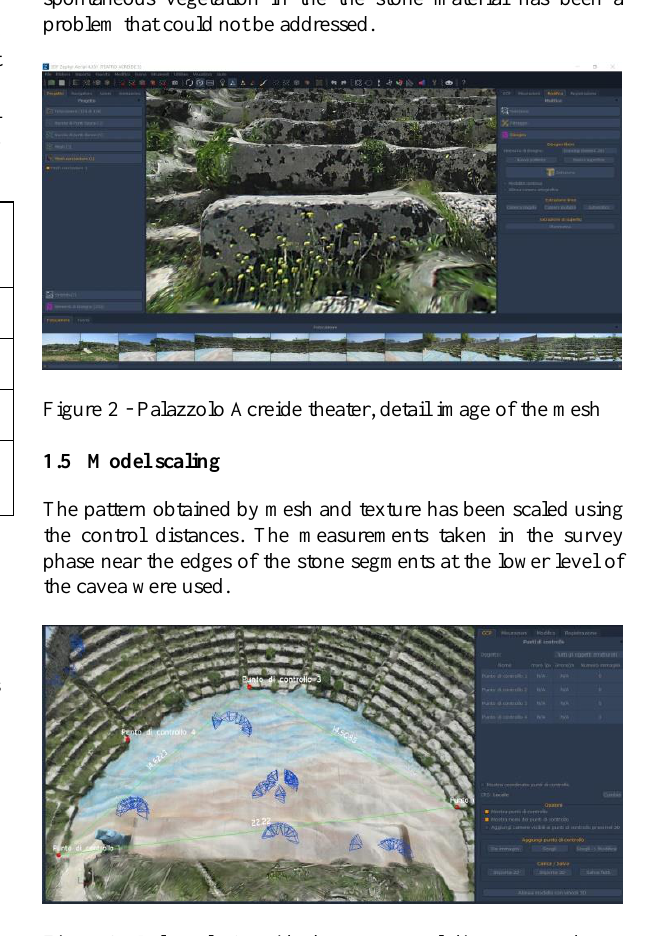
Figure 3 - Palazzolo Acreide theatre, control distances